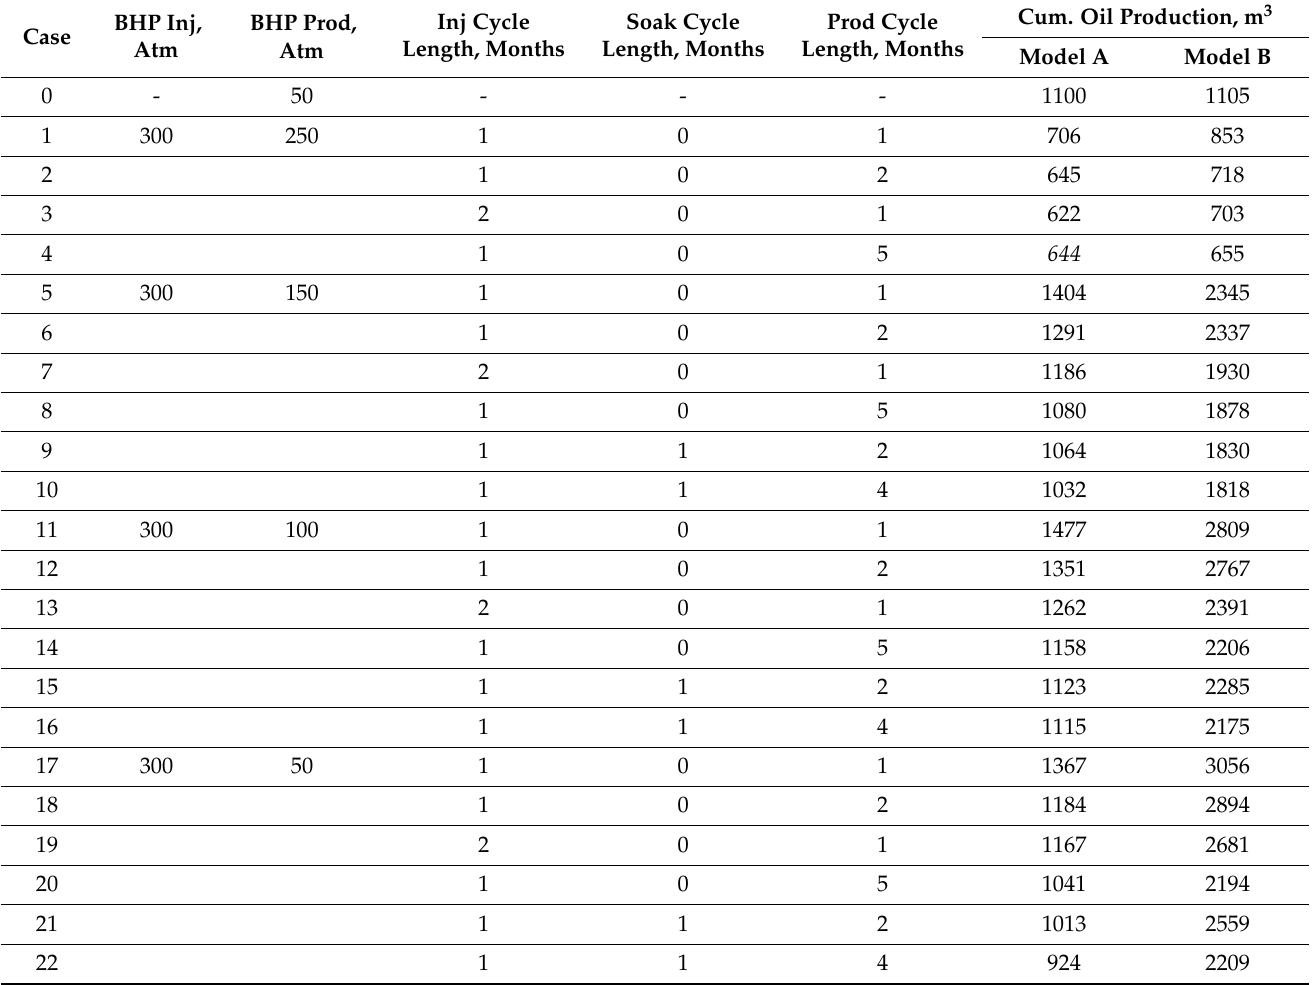
Table 3. Simulated scenarios and results for models A and